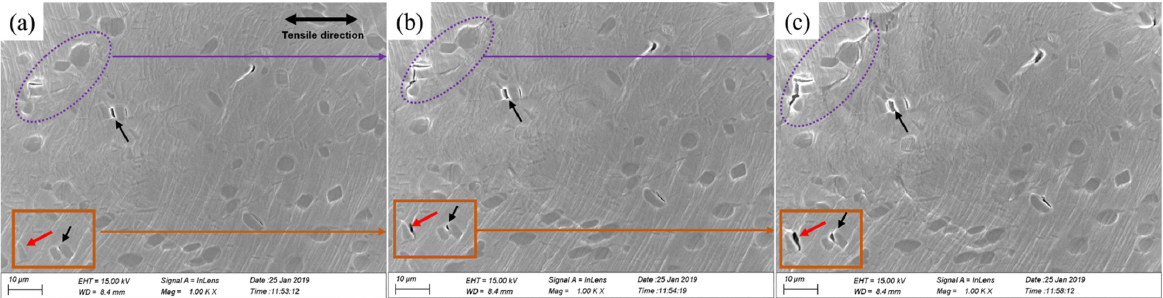
Figure 13. ( a ) {110} and <111> pole figures of the B2 phase, ( b ) {0001} and <1120> pole figures of the #26 α 2 particle.